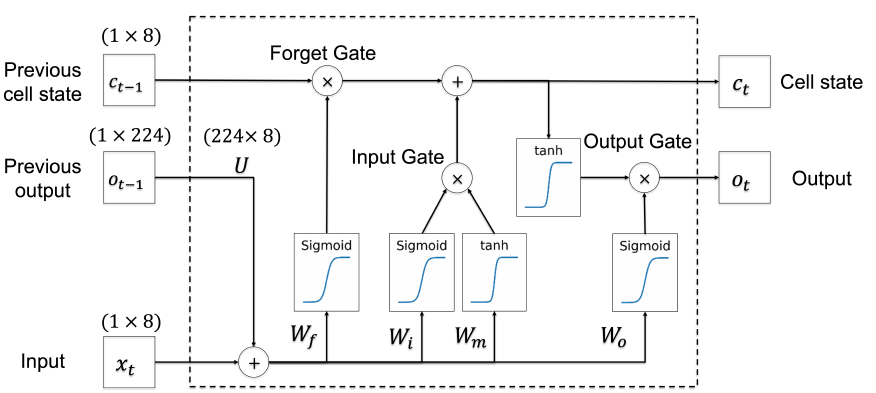
Figure A1. Details inside an LSTM layer.